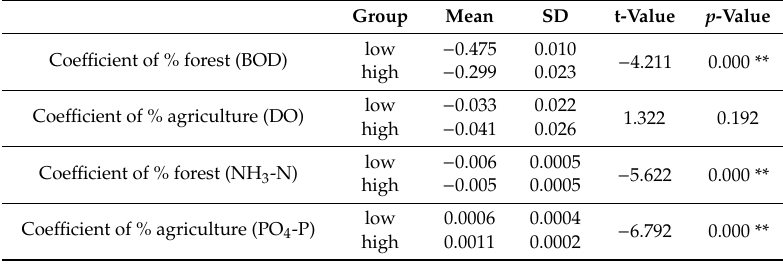
Table 7. t -Test results comparing group 1 (the percentage of land use is below the mean) and group 2 (the percentage of land use is above the